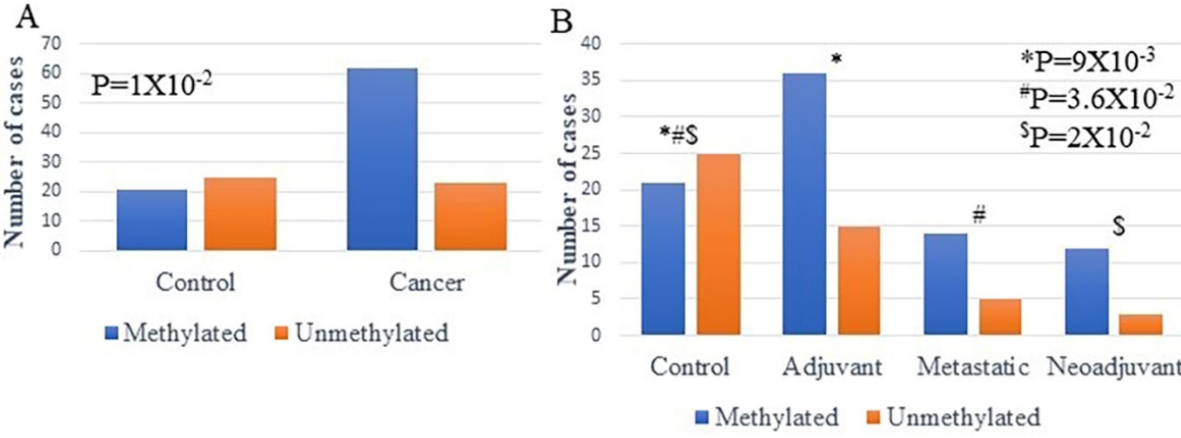
Figure 4. Methylation of ENPP2 estimated by qMSP in ccfDNA ( A ) from BrCa patients and healthy individuals ( B ) from each group separately (adjuvant, metastatic, neoadjuvant, and healthy). Ab- breviations: ccfDNA: circulating cell-free DNA; qMSP: quantitative methylation-specific PCR; CRC: colorectal cancer. * Control in relation to Adjuvant, # Control in relation to Metastatic, $ Control in relation to Neoadjuvant.